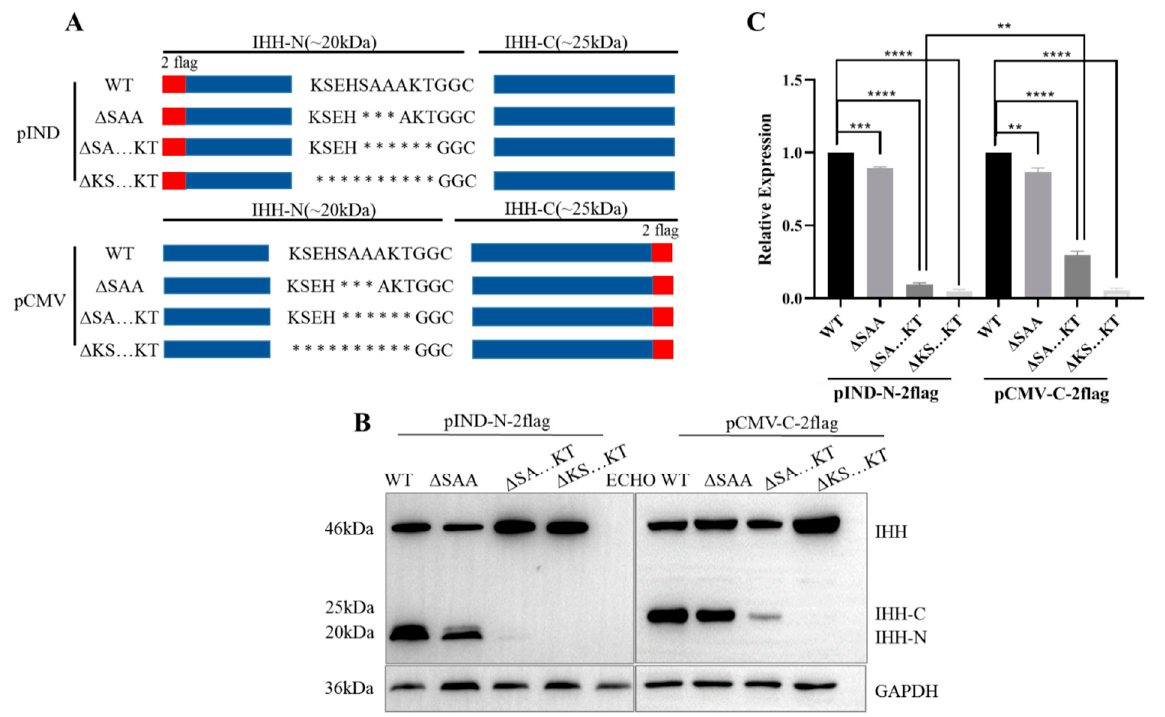
Figure 2. Conserved C -terminal region of IHH-N affects protein self-cleavage and stability. ( A ) Schematic of different truncations. * truncated amino acids. ( B , C ) Western blot and quantitative statistical analysis of the different truncations. The grey value of the protein bands was analysed by Image J. The ratio of IHH-N (or IHH-C) to the total IHH protein, which is composed of full-length protein and IHH-N (or IHH-C), was calculated with the WT as the standard. Data are mean ± s.e.m, n = 3, ** p < 0.01, *** p < 0.001, **** p < 0.0001. The IHH-N and IHH-C fragments were slightly reduced in Δ SAA and remarkably less in Δ SA…KT than that in WT. IHH-N and IHH-C were not detected completely in Δ KS...KT.